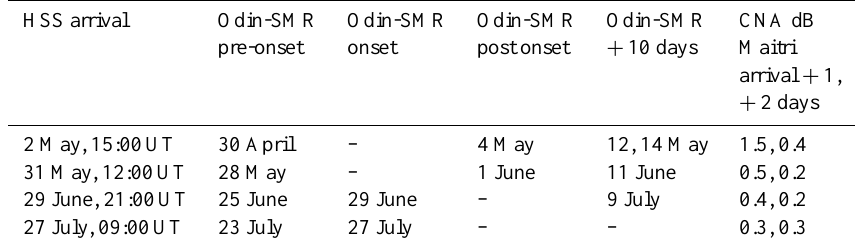
Table 2. Time of HSS arrival, dates of available Odin-SMR measurements of NO profiles, and mean CNA measured between 07:00 and 11:00UT (approx. 08:00–12:00LT, 06:00–10:00MLT) by the 38.2MHz riometer at Maitri, on the 2 days following the HSS arrival, during austral winter